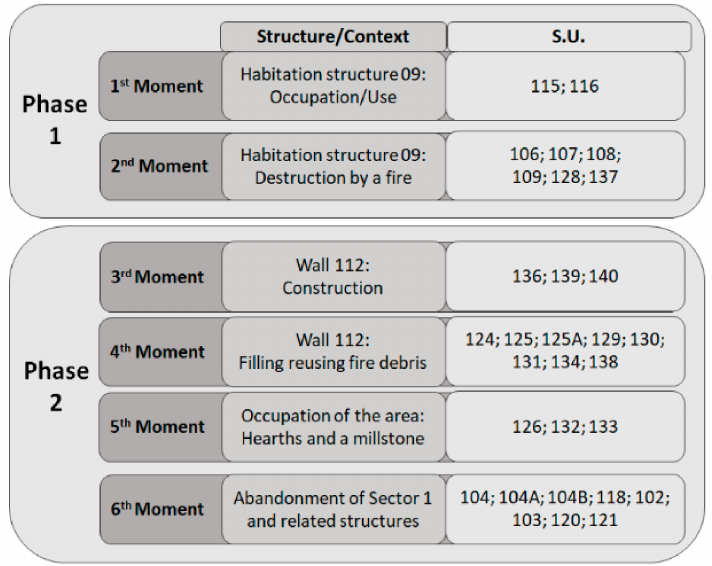
Figure 3. Relation between the archaeological contexts, structures, and site